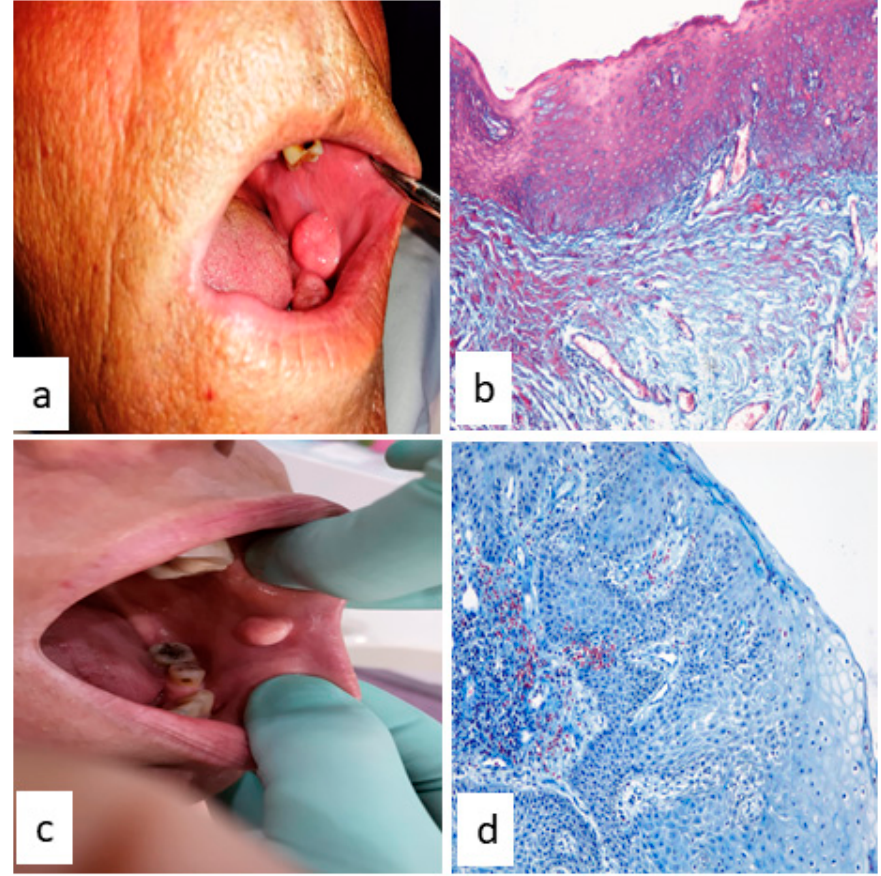
Figure 4. HPV-negative oral papilloma ( a , b ) and HPV-positive papilloma ( c , d ). ( a ) Macroscopically, tumor lesion located at the jugal mucosa, round shape, size 0.75 mm, pinkish-whitish color, poorly vascularized, non-bleeding; ( b ) Histological aspect of jugal mucosa; acanthosis, parakeratosis and koilocytes presence in the epithelium, (trichrome stain × 200); ( c ) Macroscopically, tumor lesion located at the occlusal line of the jugal mucosa, round-oval shape, size 0.95 mm, red color, richly vascularized, bleeding at the slightest trauma; ( d ) Hiper- and parakeratosis, acanthosis and koilocytes presence in the epithelium; in the basal epithelial layer mitotic figures are present. Proinflammatory cells infiltrate the mucosa (trichrome stain ×